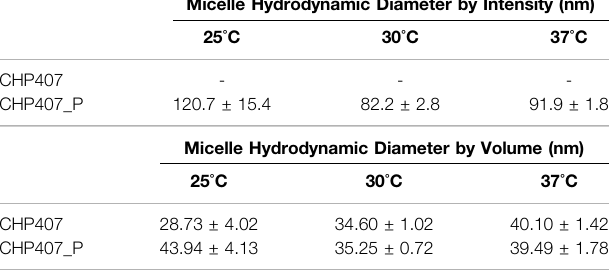
TABLE 2 | Micelle average hydrodynamic diameters by intensity and by volume measured for CHP407 and CHP407_P solutions (0.5% w/V concentration) at 25 ° C, 30 ° C, and 37 °